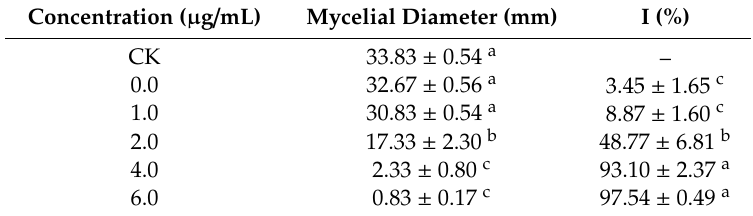
Table 1. Effect of different MNQ concentrations on mycelial growth of P. italicum 1 .